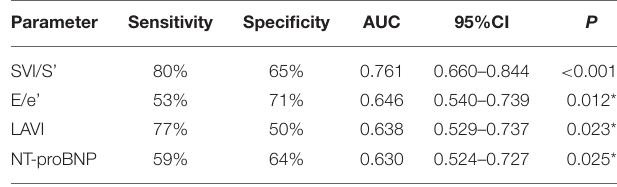
AUC, area under the curve; CI, confidence interval; E/e’, the ratio of early diastolic transmitral velocity to early diastolic septal myocardial velocity; LAVI, left atrial volume index; NT-proBNP, N-terminal pro-brain natriuretic peptide; SVI/S’, the ratio of body surfaceareastandardizedstrokevolume(SVI)normalizedbytissueDopplermitralannulus systolic peak velocity. * P < 0.05.